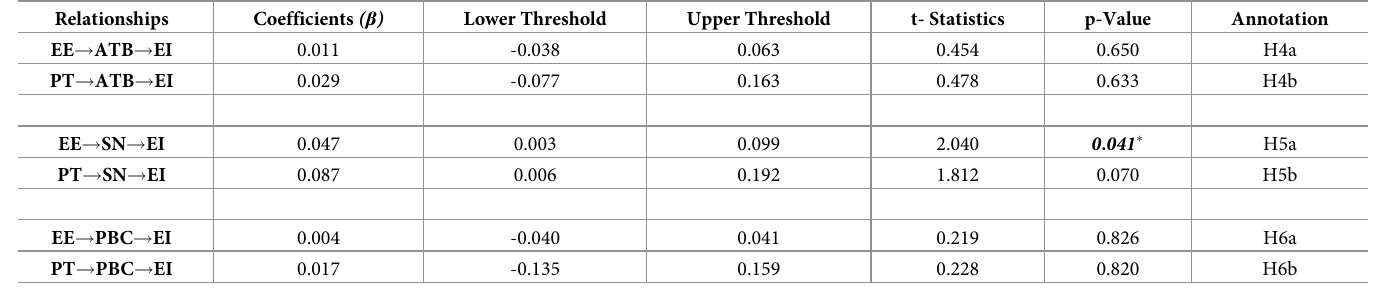
Table 6. Structural specific indirect effects of the male sample.